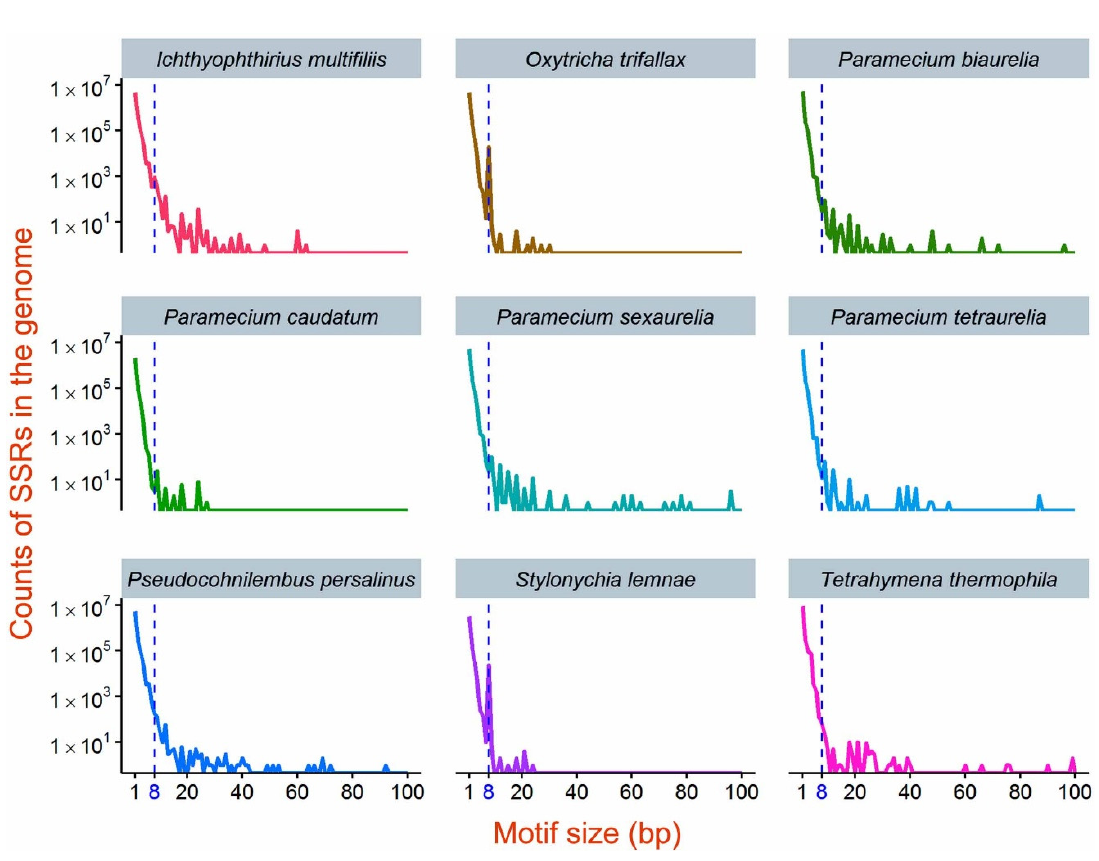
Figure 1. Counts of simple sequence repeats (SSRs) with 1–100 bp motifs ( ≥ three repeats) in the nine ciliate macronuclear genomes. The y-axis is log10 transformed. Table 2. Macronuclear simple sequence repeats information.